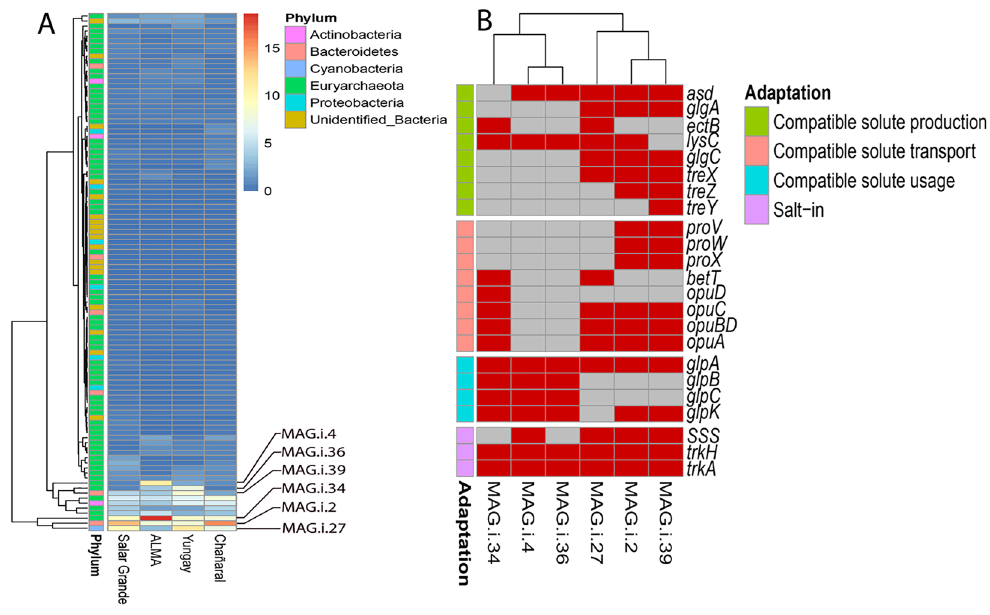
Figure 5. Taxonomic and functional characterization of MAGs across sites. ( A ) Taxonomic annotation and relative abundance of MAGs across sites; labeled are the most abundant site-specific MAGs; color-coded legend is in %. ( B ) Presence (red boxes) and absence (grey boxes) of genes involved in compatible solute production, transport, and utilization in the site-specific MAGs.